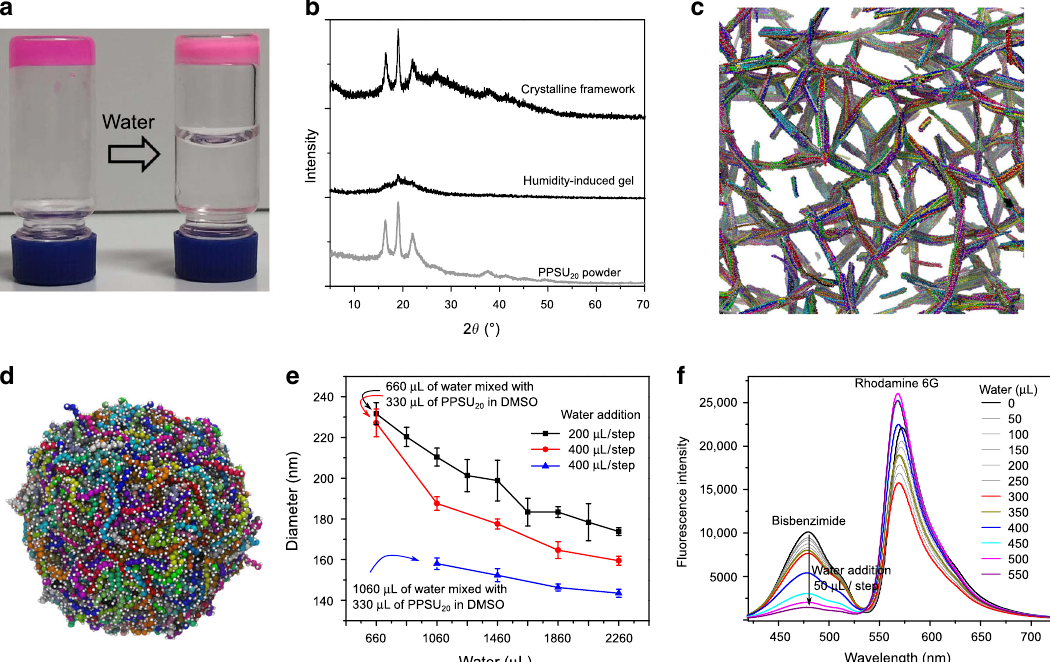
Fig. 3 Mechanism of PPSU dynamic network self-assembly. a Slow hydration leading to the crystalline framework. The PPSU 20 hydrogel (colored by rhodamine B) was prepared by aging a DMSO solution of PPSU 20 (200 mg mL − 1 ) in humidity for 3 days. Adding an excess amount of water on the top of the gel allows slow solvent replacement for dense sulfone – sulfone bonding, which induces crystallization. b WAXD patterns for the humidity-induce gel, crystalline framework, and for comparison the powdered solid PPSU 20. c – d CGMD simulation snapshots showing the formation of bundles by rigid chains and a spherical hydrogel by fl exible chains. Oxygen atoms are represented by the white spheres. e Collapse of PPSU 20 networks as indicated by the decreasing nanogel size upon stepwise hydration. Error bars represent the standard deviation from three parallel experiments. f Collapse of PPSU 20 assemblies enabling FRET from bisbenzimide to rhodamine 6 G. Bisbenzimide (0.01 mg mL − 1 ) and rhodamine 6 G (0.01 mg mL − 1 ) were added to 1 mL of DMSO solution of PPSU 20 (5 mg mL − 1 ), followed by fl uorescence titrations of the system with water (50 μ L per step, E x = 375